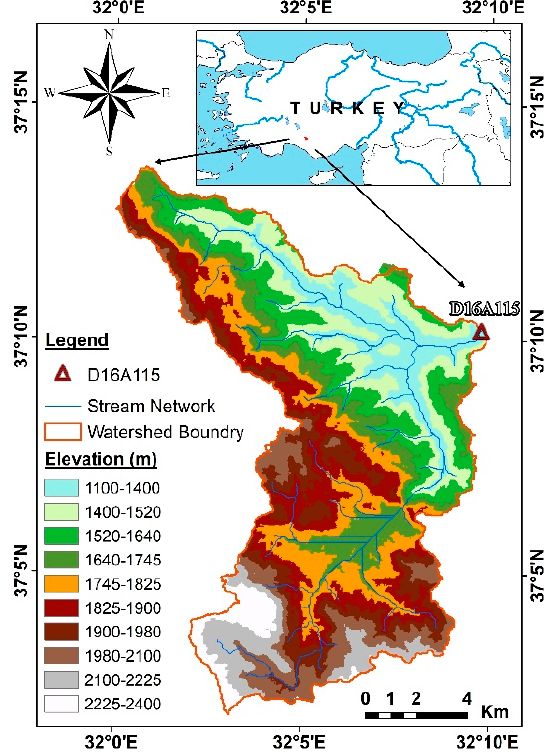
Figure 1. The location map of the study area.